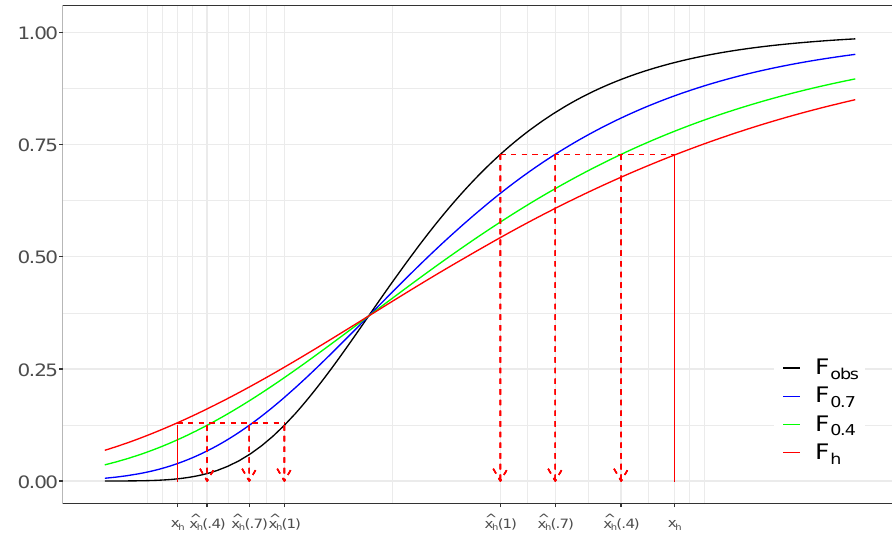
Figure 2. A sketch of quantile mapping with various α -corrections, where the historical simulated cumulative distribution function (cdf)( F h ) is mapped onto the α -corrected cdfs. F obs is the cdf of the observations, and F 0.4 and F 0.7 are 0.4- and 0.7-corrected cdfs, respectively. ˆ x h ( α ) is the α -corrected value of the historical data ( x h